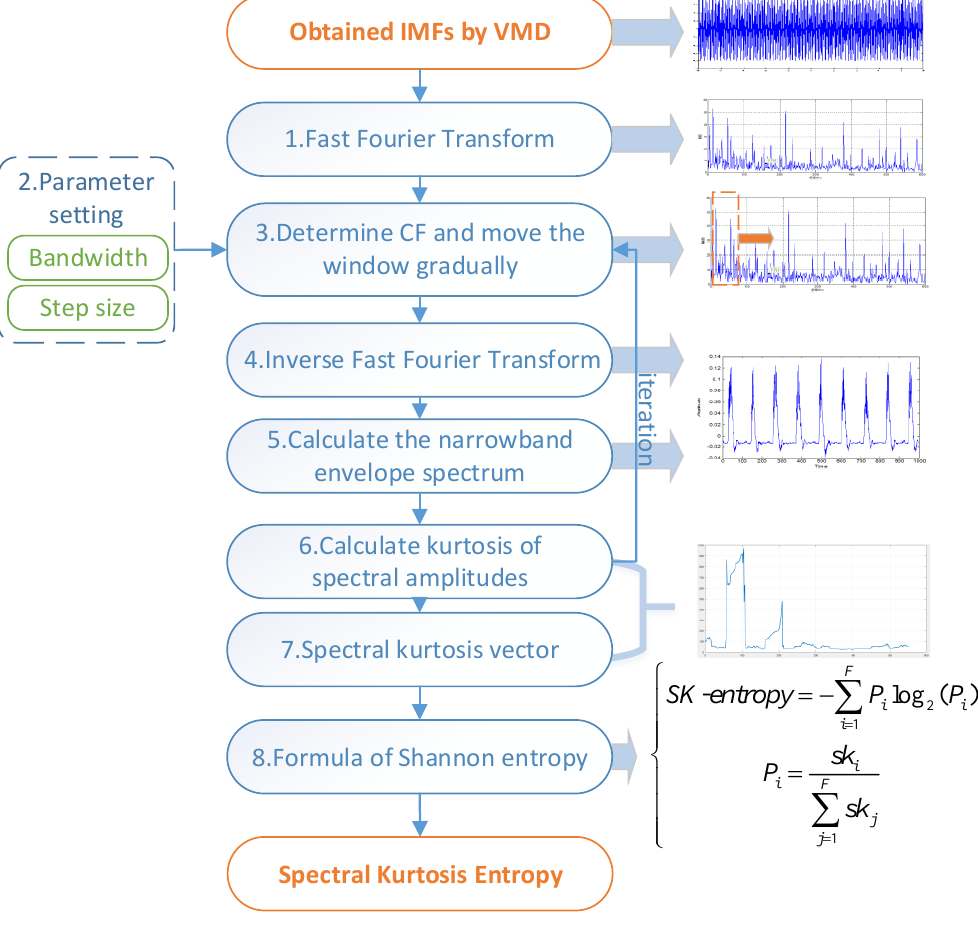
Figure 1. The procedure of spectral kurtosis entropy.